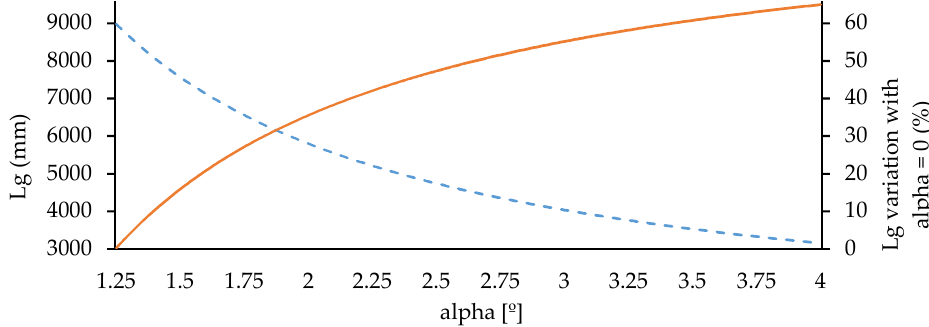
Figure 3. Variation of Lg with the conical angle of the connection (dashed line) and the percent difference between L g (α = i) and L g (α = 0) (solid line).